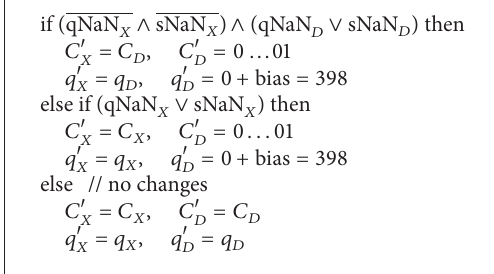
Algorithm 7: Algorithm of NaN